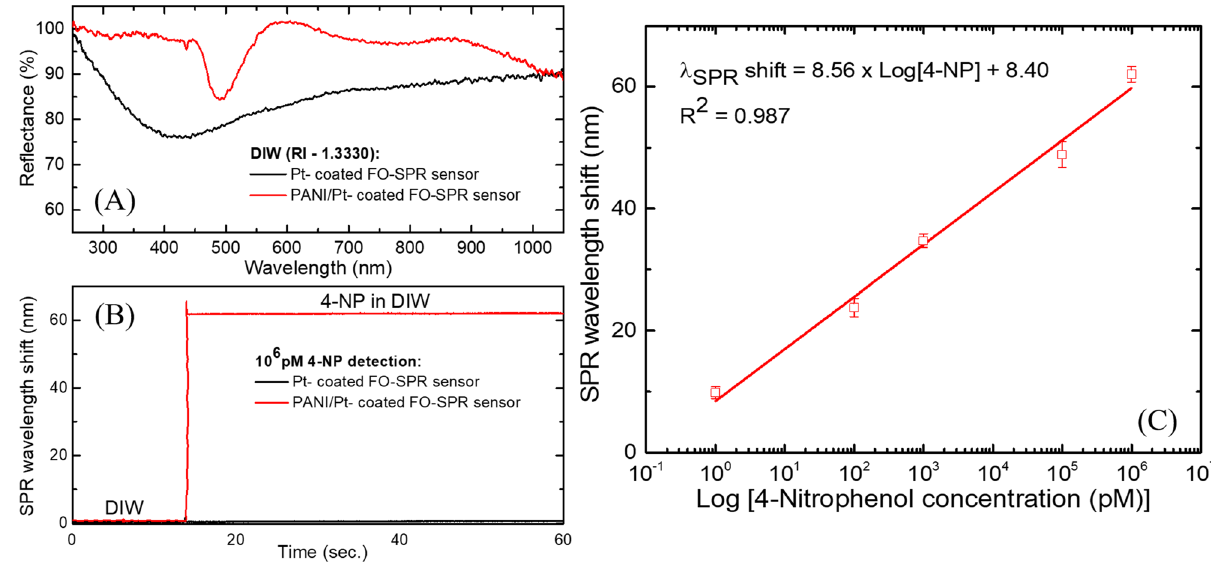
Figure 6. Detection of 4-NP in DIW samples. ( A ) SPR spectral dips obtained in DIW with Pt-coated (black) and PANI/Pt-coated (red) FO-SPR sensors, respectively; ( B ) Specificity test, showing that in the absence of PANI layer a SPR wavelength shift of less than 1 nm is recorded for the solution containing 10 6 pM 4-NP in DIW; ( C ) Calibration plot showing a linear relationship between the PANI/Pt-coated FO-SPR wavelength shift and the logarithm of 4-NP concentrations. The error bars indicate the standard deviation (n = 3). Processed using Origin 9.6.0.172 (OriginLab 2019), https:// www. origi nlab. com/.